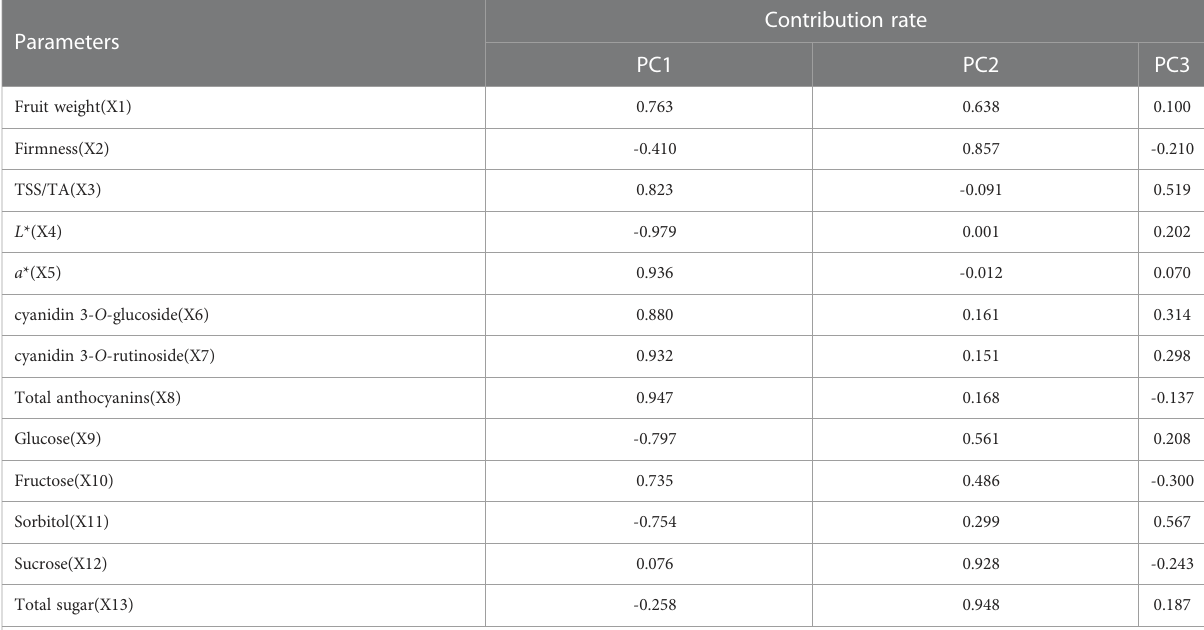
TABLE 3 Component